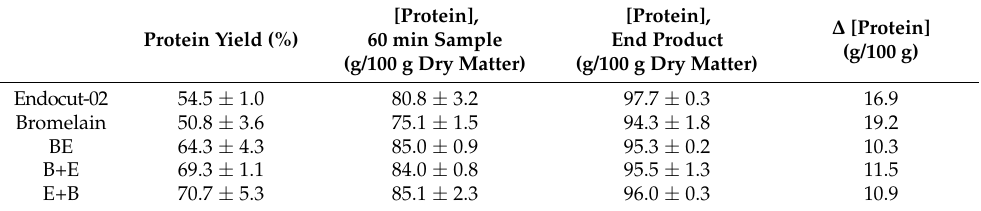
Table 5. The resulting protein yield (% of proteins liberated from start material), the protein con- centration (g/100 g dry matter) in the 60 min sample taken during hydrolysis, and in the final product hydrolysate after MDCR hydrolysis (40 ◦ C, 1 h). Hydrolysis was performed using either Endocut-02 or Bromelain, a combination of both for the full hour (BE), or adding either Bromelain or Endocut-02 30 min before adding the other protease (B+E or E+B) (errors given in SD of replicate hydrolysates). The ∆ [protein] column shows the difference between the end product and 60 min sample protein